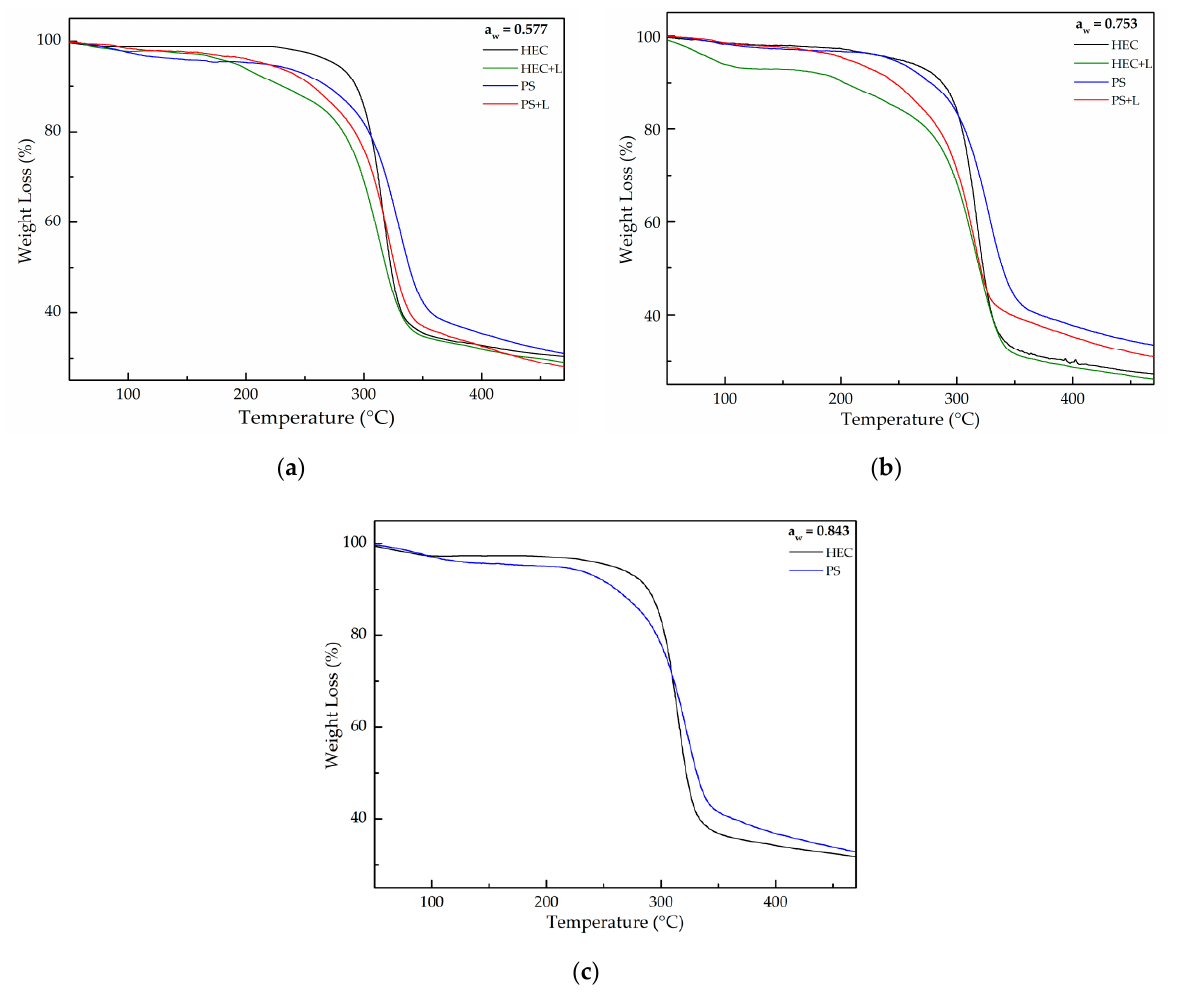
Figure 4. Weight loss as a function of temperature for the prepared films exposed to ( a ) 0.577; ( b ) 0.753; ( c ) 0.843 a w .